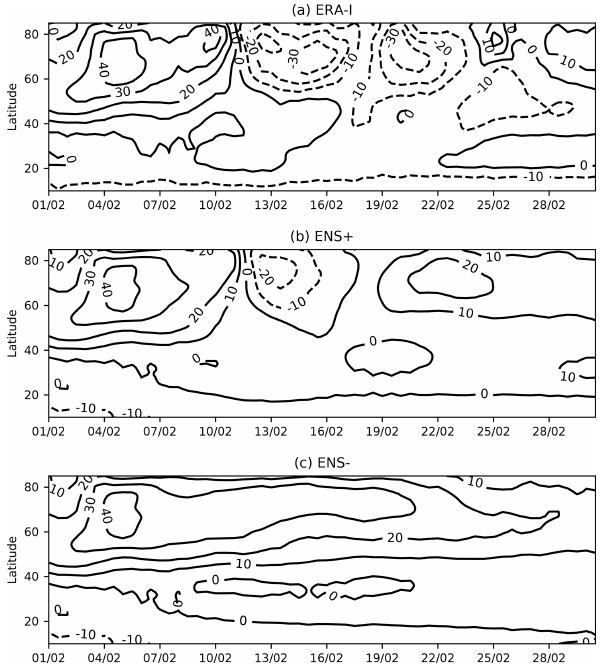
Figure 2. Latitude–time cross sections of zonal-mean zonal winds (ms − 1 ) at 10hPa during February 2018. (a) ERA-I; (b) com- posite of ENS + members; (c) composite of ENS − members. Con- tour intervals are 10ms − 1